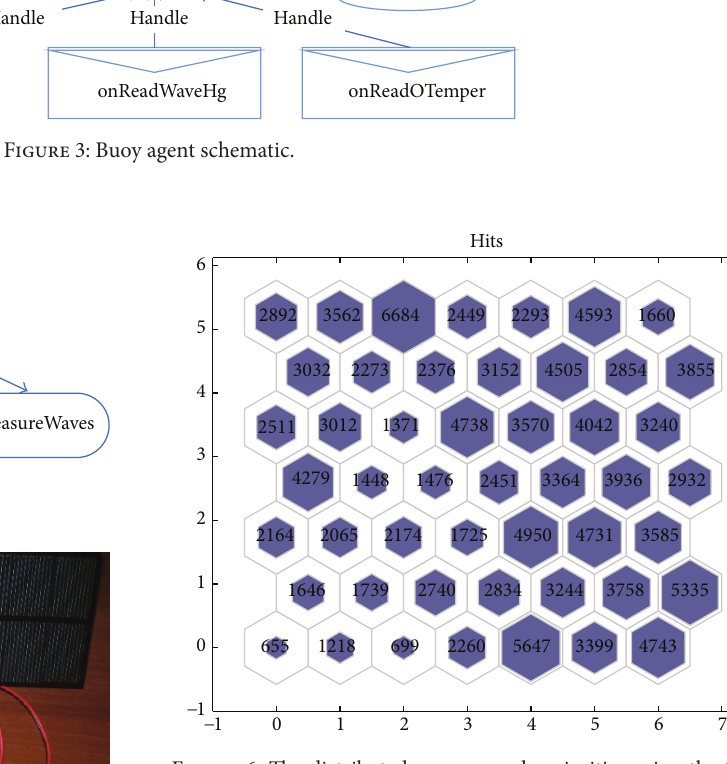
Figure 6: The distributed sensory node priorities using the SOM neural